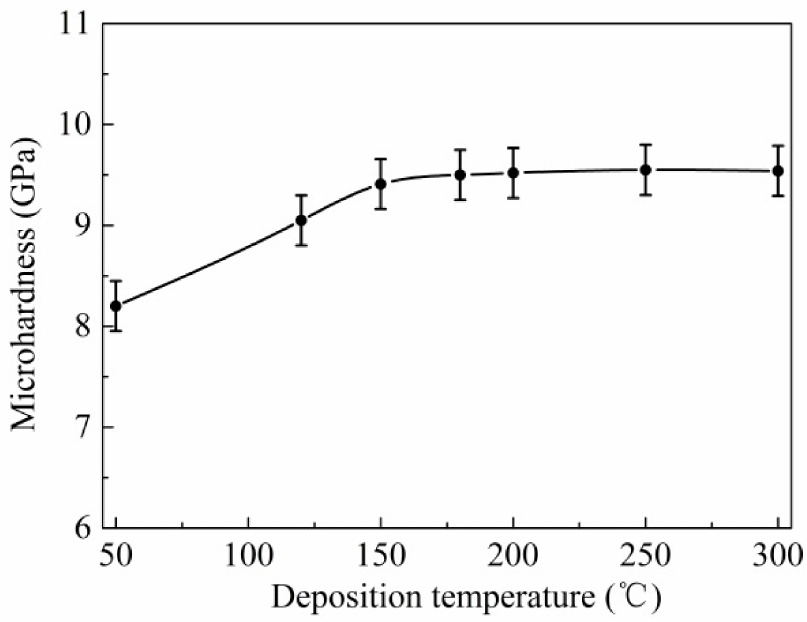
Figure 9. Surface microhardness of coatings at different deposition